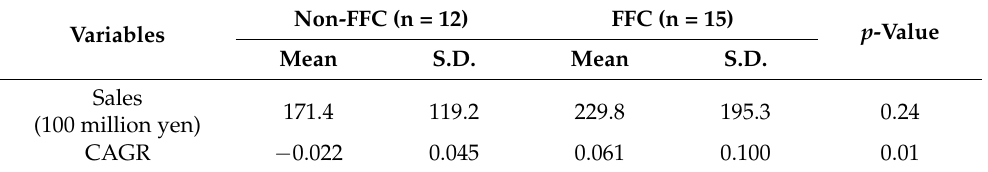
Table 4. Sales and CAGR of 12 companies without food with function claims (FFC) and 15 companies with FFC.